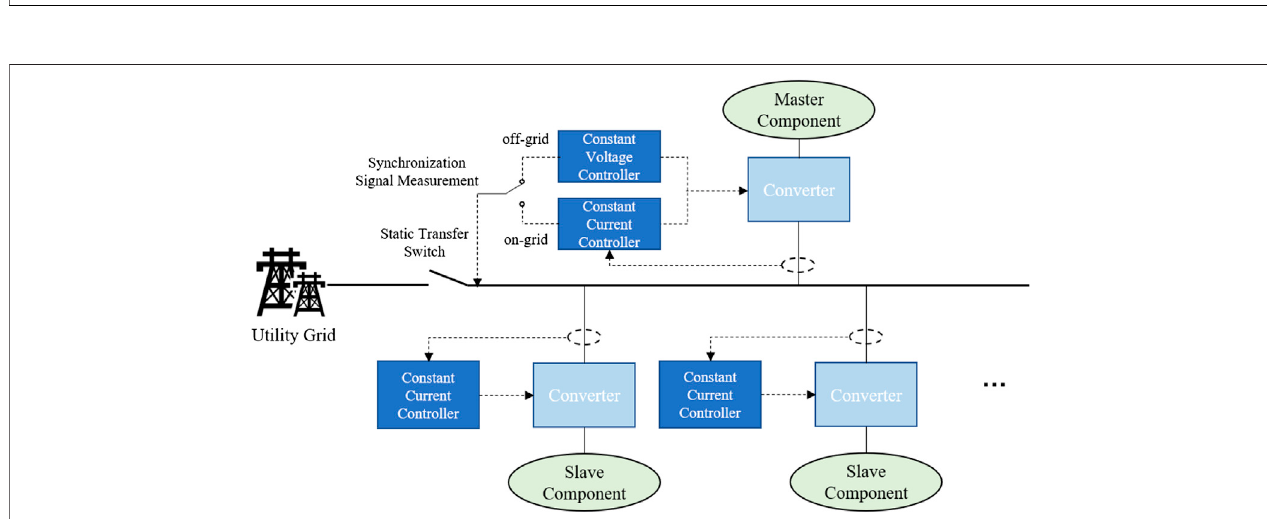
FIGURE 3 | The neural network of ANN-based MPPT. (A) The method based on electrical data; (B) The method based on non-electrical data; (C) The method based on mixed data.